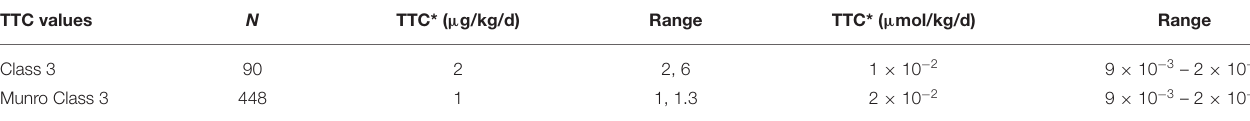
TABLE 5 | TTC values of non-genotoxic datasets and original datasets by Munro for Cramer Class 3 with respective ranges after randomly removing